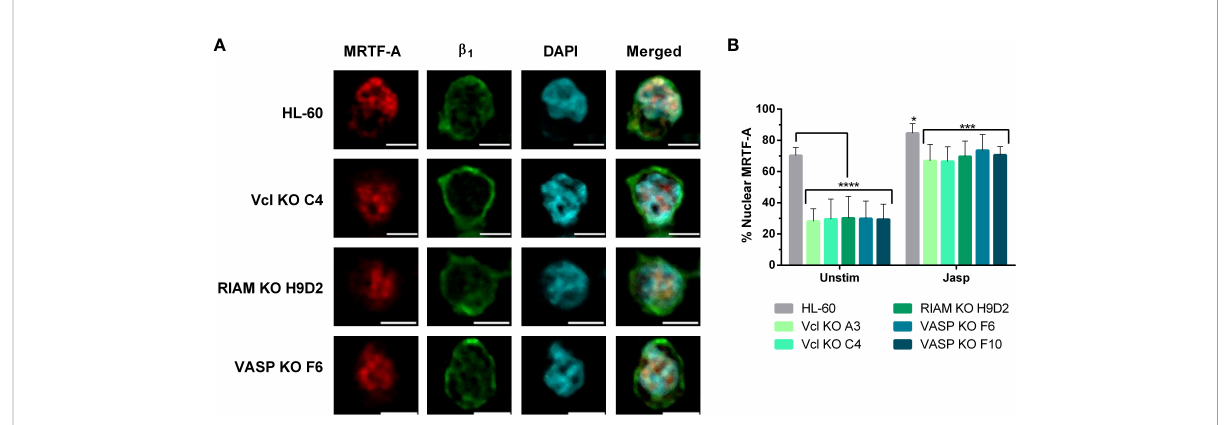
FIGURE 6 Jasplakinolide induces MRTF-A nuclear translocation in Vinculin, RIAM and VASP knockouts. (A) Differentiated HL-60 parental cells and HL-60 knockouts for Vcl, RIAM and VASP were adhered to slides, then subjected to a 1 µM 2 h jasplakinolide stimulation, fi xed, permeabilized and fl uorescently stained to determine MRTF-A localization. b 1 integrin was used to delimit the plasma membrane and DAPI was used as a nuclear stain. Confocal microscopy images were analyzed using the ImageJ package and are representative results from 3 independent experiments. Bars indicate 5 µm. (B) Quanti fi cation images from the untreated cells shown on Figure 4 and jasplakinolide-treated cells on (A) . Results are represented as relative to the wild-type nuclear ratio and are from 3 independent experiments with at least 50 cells. Data are presented as mean ± SD, where the error bars denote standard deviation. Signi fi cance (ANOVA) has been calculated with respect to HL-60 controls, * denotes p<0.05, ***,p<0.005, and